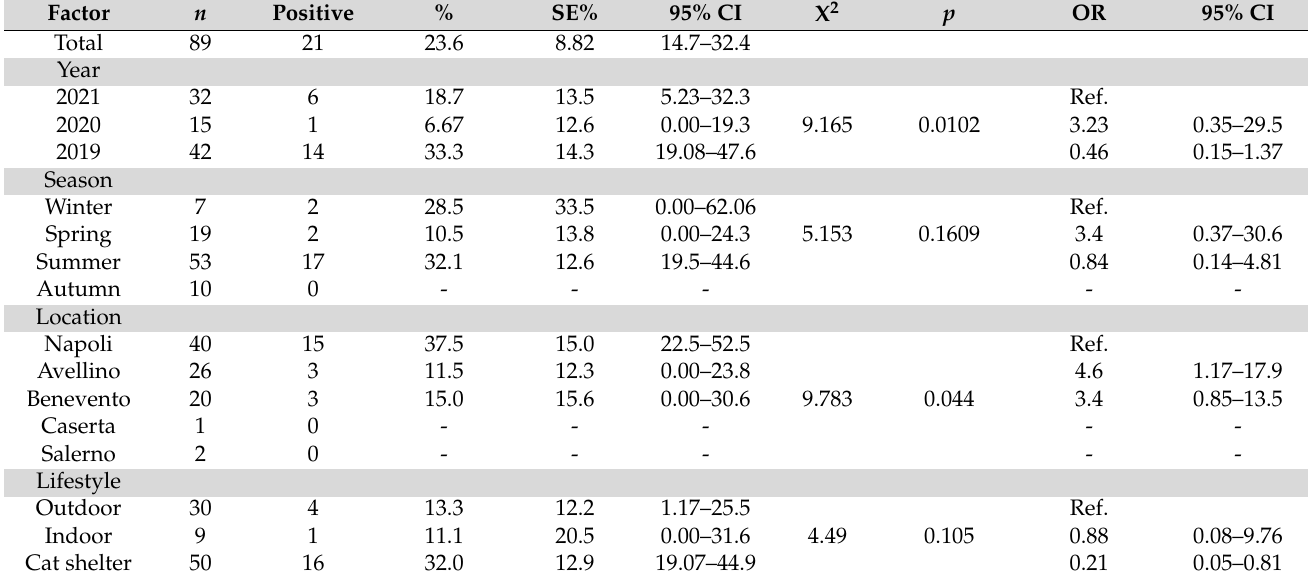
Table 4. FeLV infection prevalence and risk factor analysis in cats from Campania Region